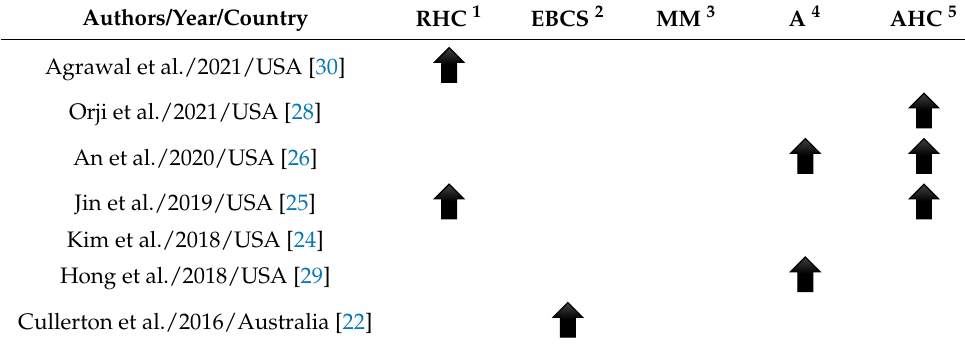
Table 3. Adherence to breast cancer–screening program according to family/personal history, mar- ital status and educational level.